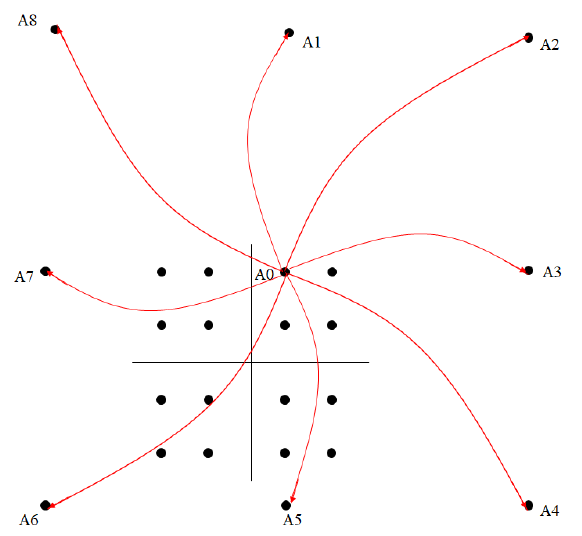
Figure 5. Expanded 16-QAM to 9 × 16-QAM constellation for tone injection (TI)